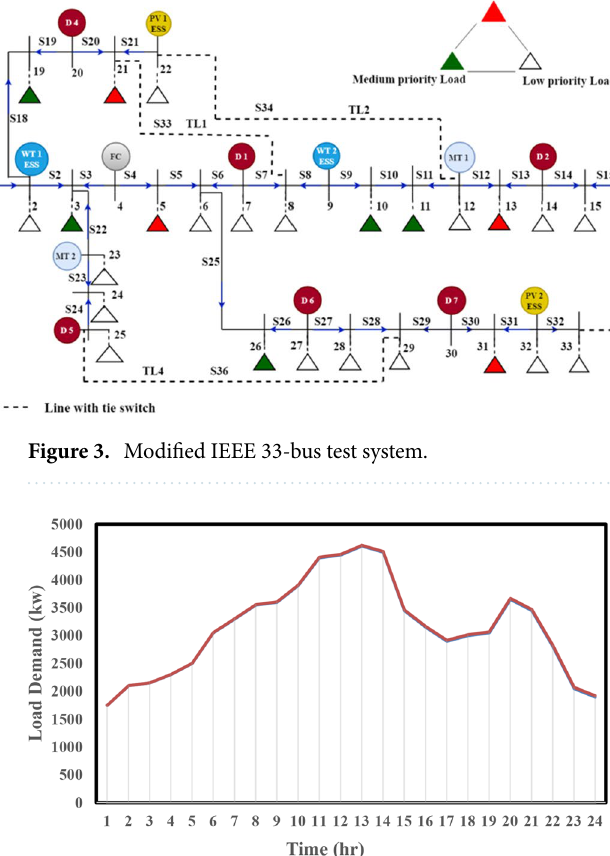
Figure 4. Hourly load demand profile for a sample day 11